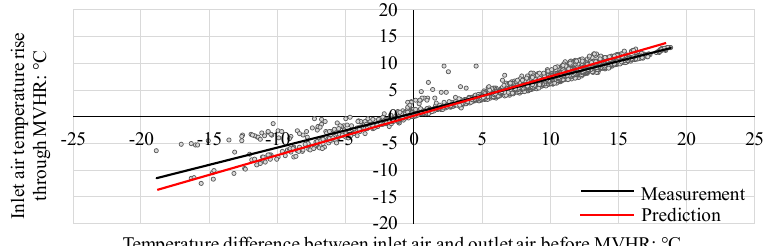
Figure 6. Measured (black) and predicted (red) air temperature rise through the MVHR versus the temperature difference between the inlet air and outlet air before the MVHR (October 2015 to March 2016).